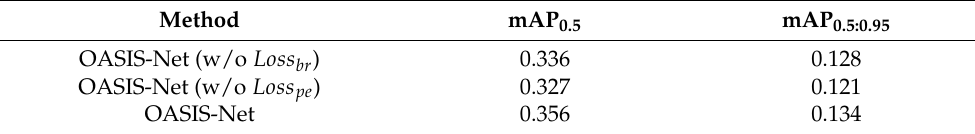
Table 7. Ablation study results of OASIS-Net for efflorescence detection.